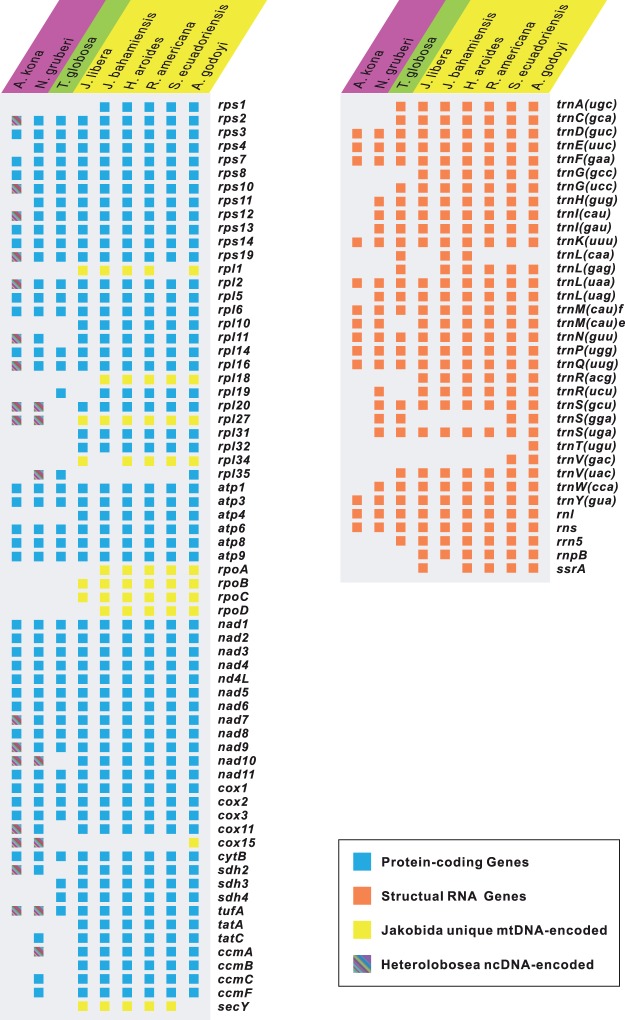
A comparison of mtDNA gene contents among representative lineages of Discoba. Taxa names are shaded in purple (Heterolobosea), green (Tsukubamonadida), and yellow (Jakobida). Genes are color-coded according to the key in the box at the bottom right. mtDNA-encoded proteins exclusively found in Jakobida are indicated according to Burger et al. (2013). Nuclear-encoded mitochondrial (NcMt) proteins of two heterolobosean species (Acrasis kona and Naegleria gruberi) were identified using jakobid mtDNA genes as query (tBLASTn, E value < 1 e−10).